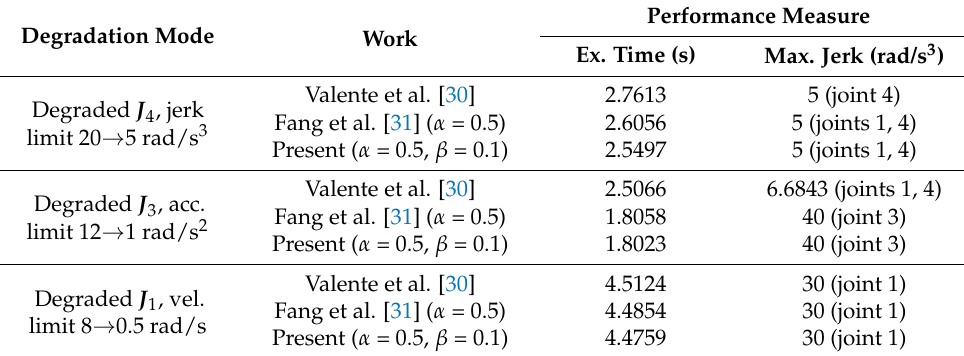
Table 4. Measured performances in different degradation